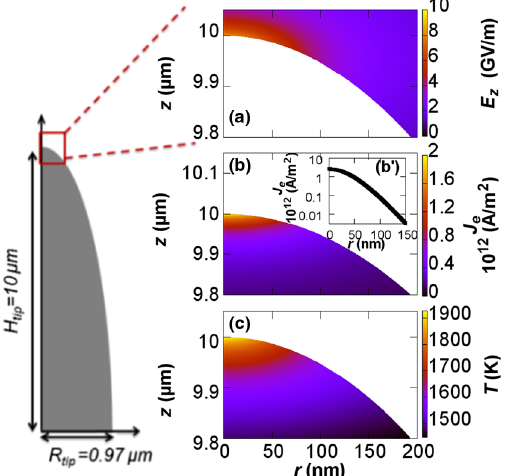
FIG. 4. 2D distributions of the electric field (a), current density (b), and temperature (c) calculated for an imposed uniform ¼ 5 × 10 7 V = m and the big tip. Surface macroscopic field E macro normal current density is represented in (b ′ ), the inset of panel